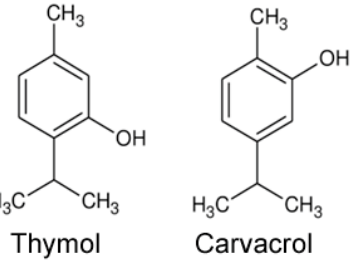
Figure 1. Structure of isopropylmethylphenols.